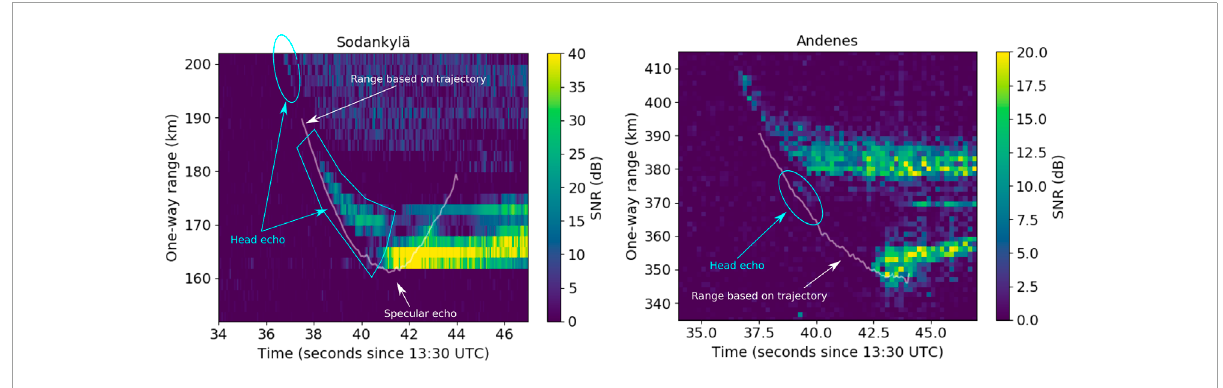
FIGURE 6 The head echo observed with the Sodankylä and Andenes meteor radars.